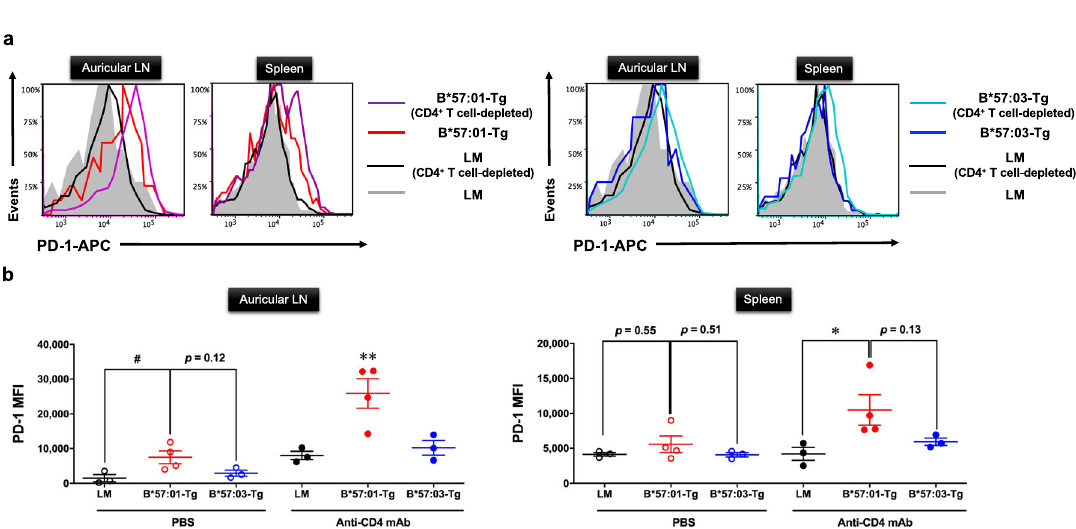
Fig. 2 PD-1 surface expression of effector memory CD8 + T cells in CD4 + T cell-depleted HLA-transgenic (Tg) mice. a Flow cytometric measurement of PD-1 surface expression. Representative histograms of PD-1 surface expression on effector memory CD8 + T cells in the auricular lymph node (LN) or spleen from CD4 + T cell-depleted/PBS-treated B*57:01-Tg mice (left panel), B*57:03-Tg mice (right panel), or their littermates (LMs). Mice have orally administrated 1% (w/w) abacavir (ABC) for 1 week. Effector memory CD8 + T cells were gated from either lymphocytes or splenocytes by anti-CD44 and CD62L antibodies (phenotype: CD44 high CD62L low ). Data are representative of three independent experiments. b Median fl uorescence intensity (MFI) values of PD-1 in effector memory CD8 + T cells isolated from the auricular LN (left panel) or spleen (right panel) of 1% (w/w) ABC-fed mice for 1 week. Each plot represents an individual mouse with the mean ± SEM ( N = 3 – 4); # p < 0.05, one-way ANOVA with Bonferroni ’ s multiple comparisons correction, compared with PBS-treated mice groups; indicated p values were obtained from a statistical comparison. * p < 0.05, ** p < 0.01, one-way ANOVA with Bonferroni ’ s multiple comparisons correction, compared with other mice groups. Data are a summary of three independent